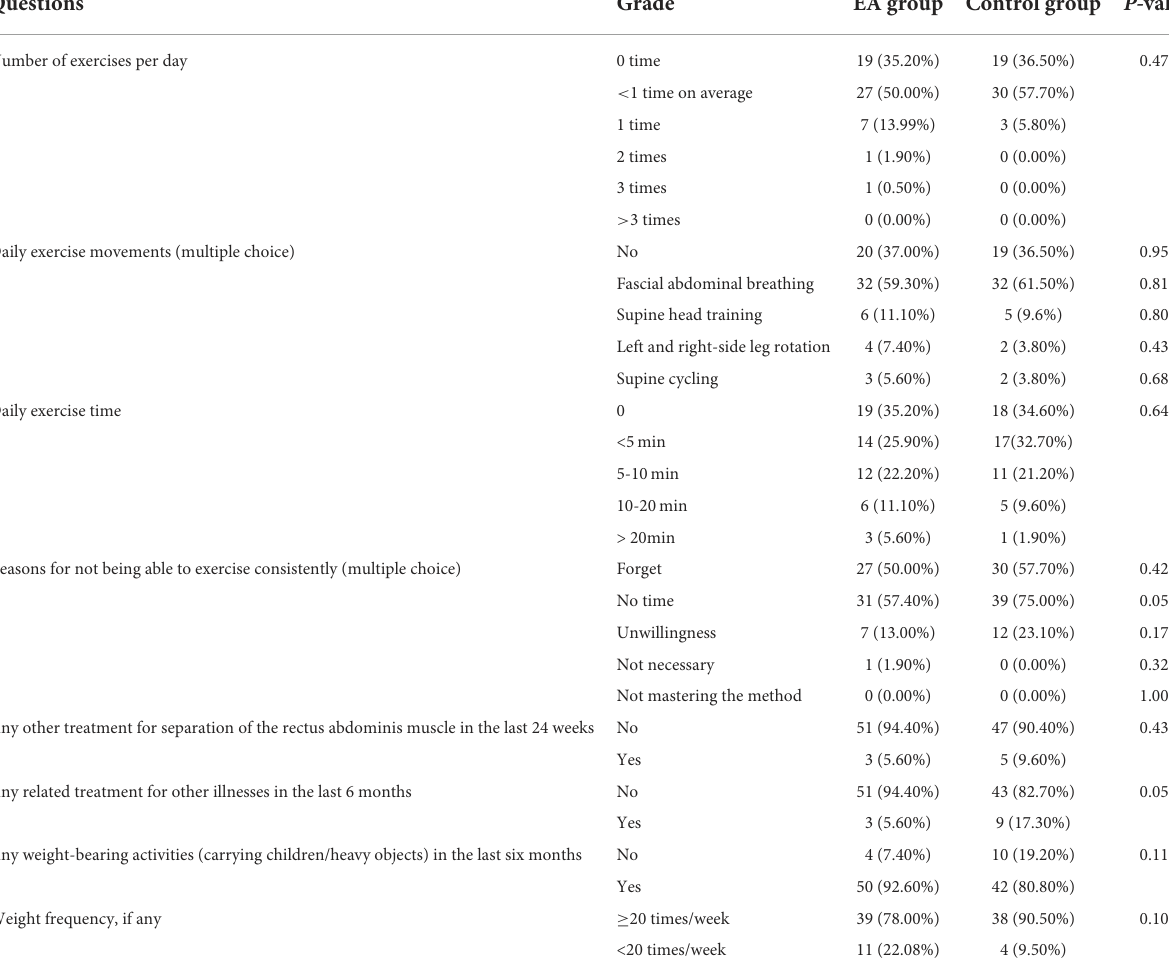
TABLE 1 The analysis of